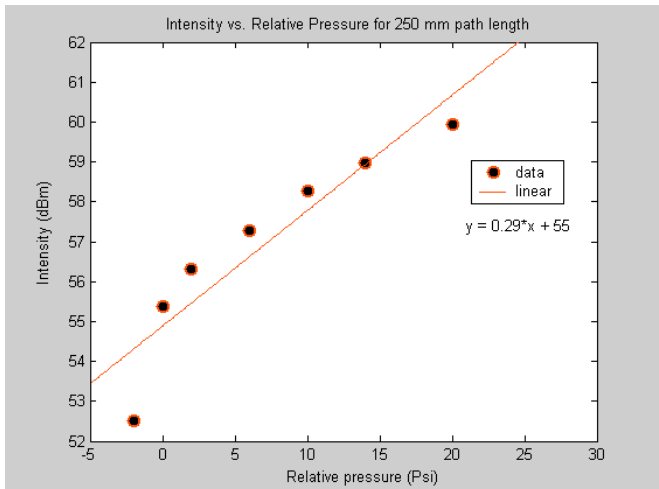
Figure 6. Intensity vs. Pressure for 250mm path length (134 µm bore